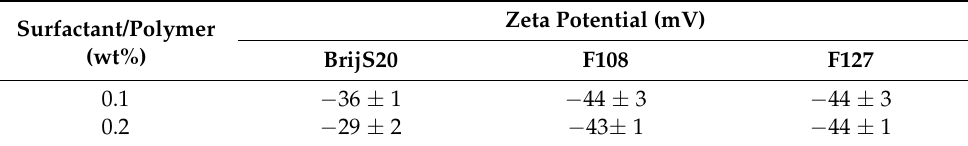
Table 2. Calculated zeta potential in 0.1 wt% CNCs.